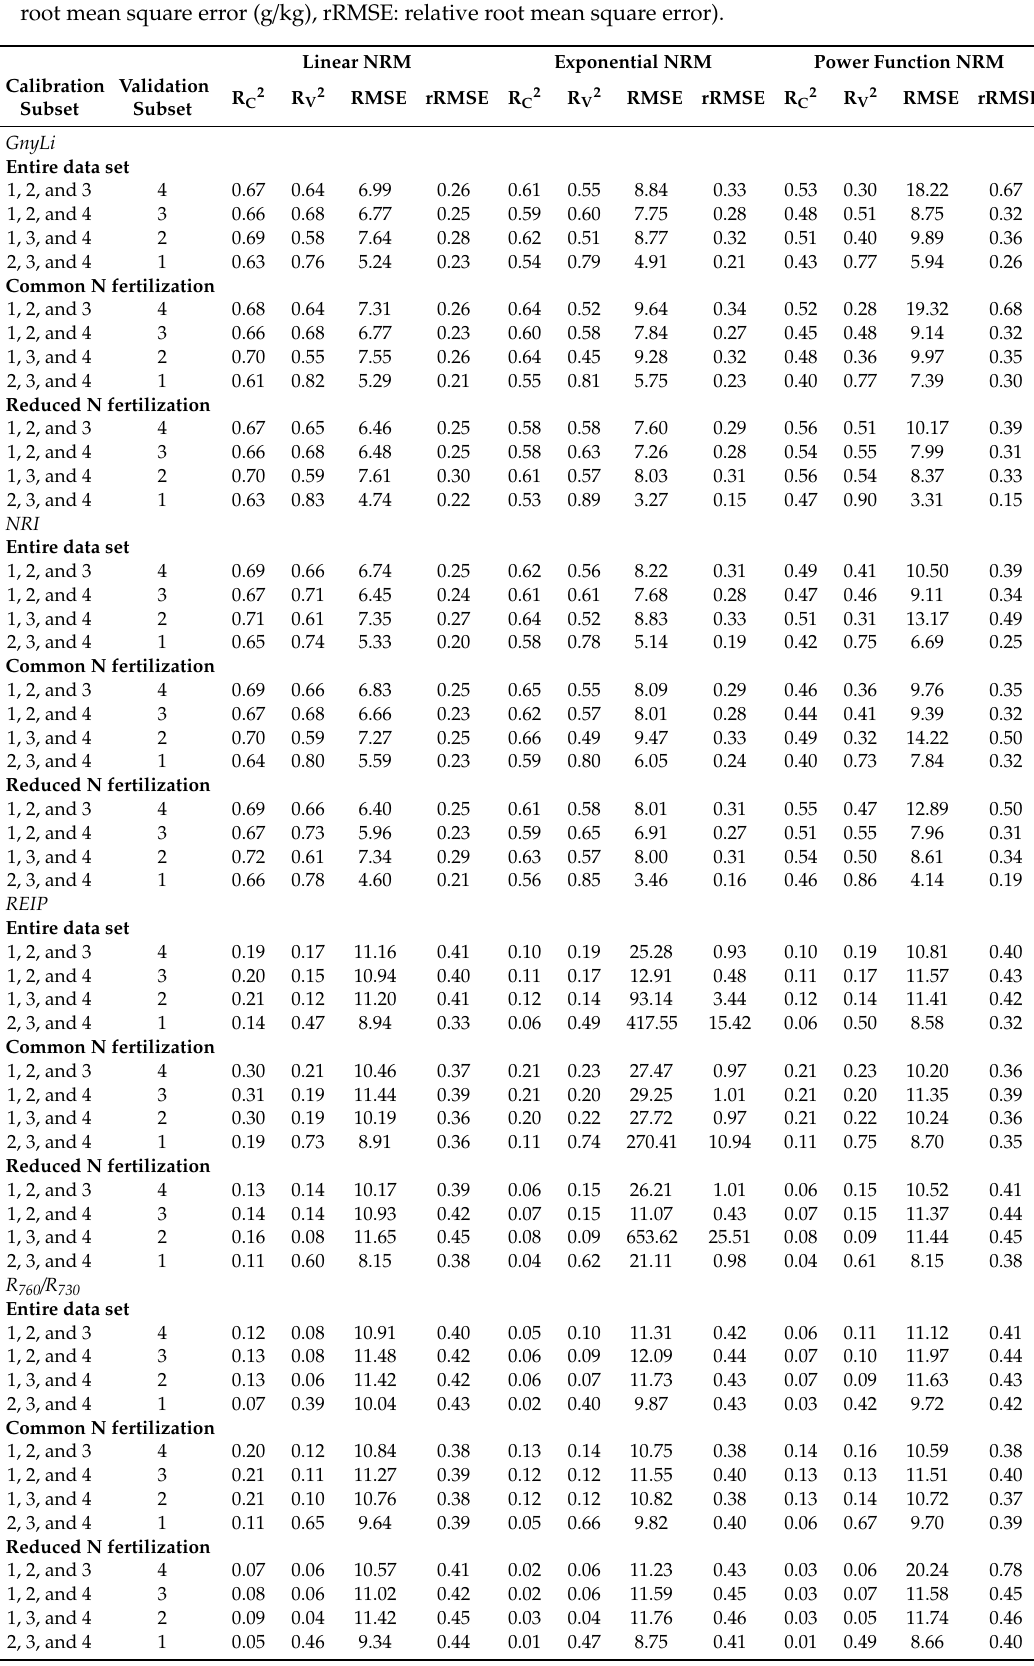
Table A4. Statistics for each run of the nitrogen regression models (NRMs) based on vegetation indices (Calibration: R C2 : coe ffi cient of determination; Validation: R V2 : coe ffi cient of determination, RMSE: root mean square error (g / kg), rRMSE: relative root mean square